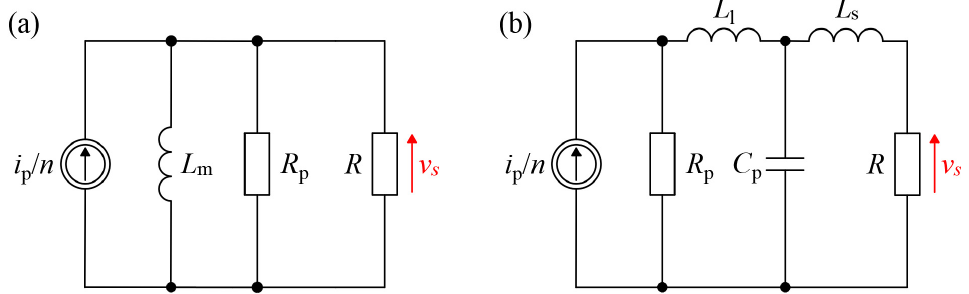
Figure 3. Proposed models of ( a ) low frequency and ( b ) high frequency.